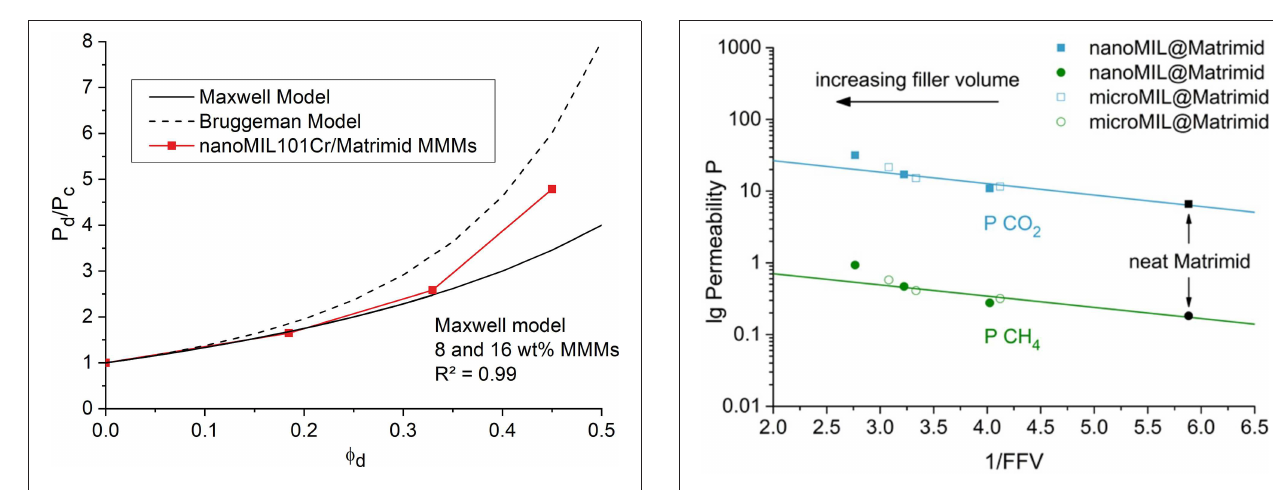
Hence, lg P plotted against the inverse FFV should give a linear correlation with slope – B p /2.303 and intercept lg A p . if indeed the FFV determines the permeability. Figure 10 shows the plot